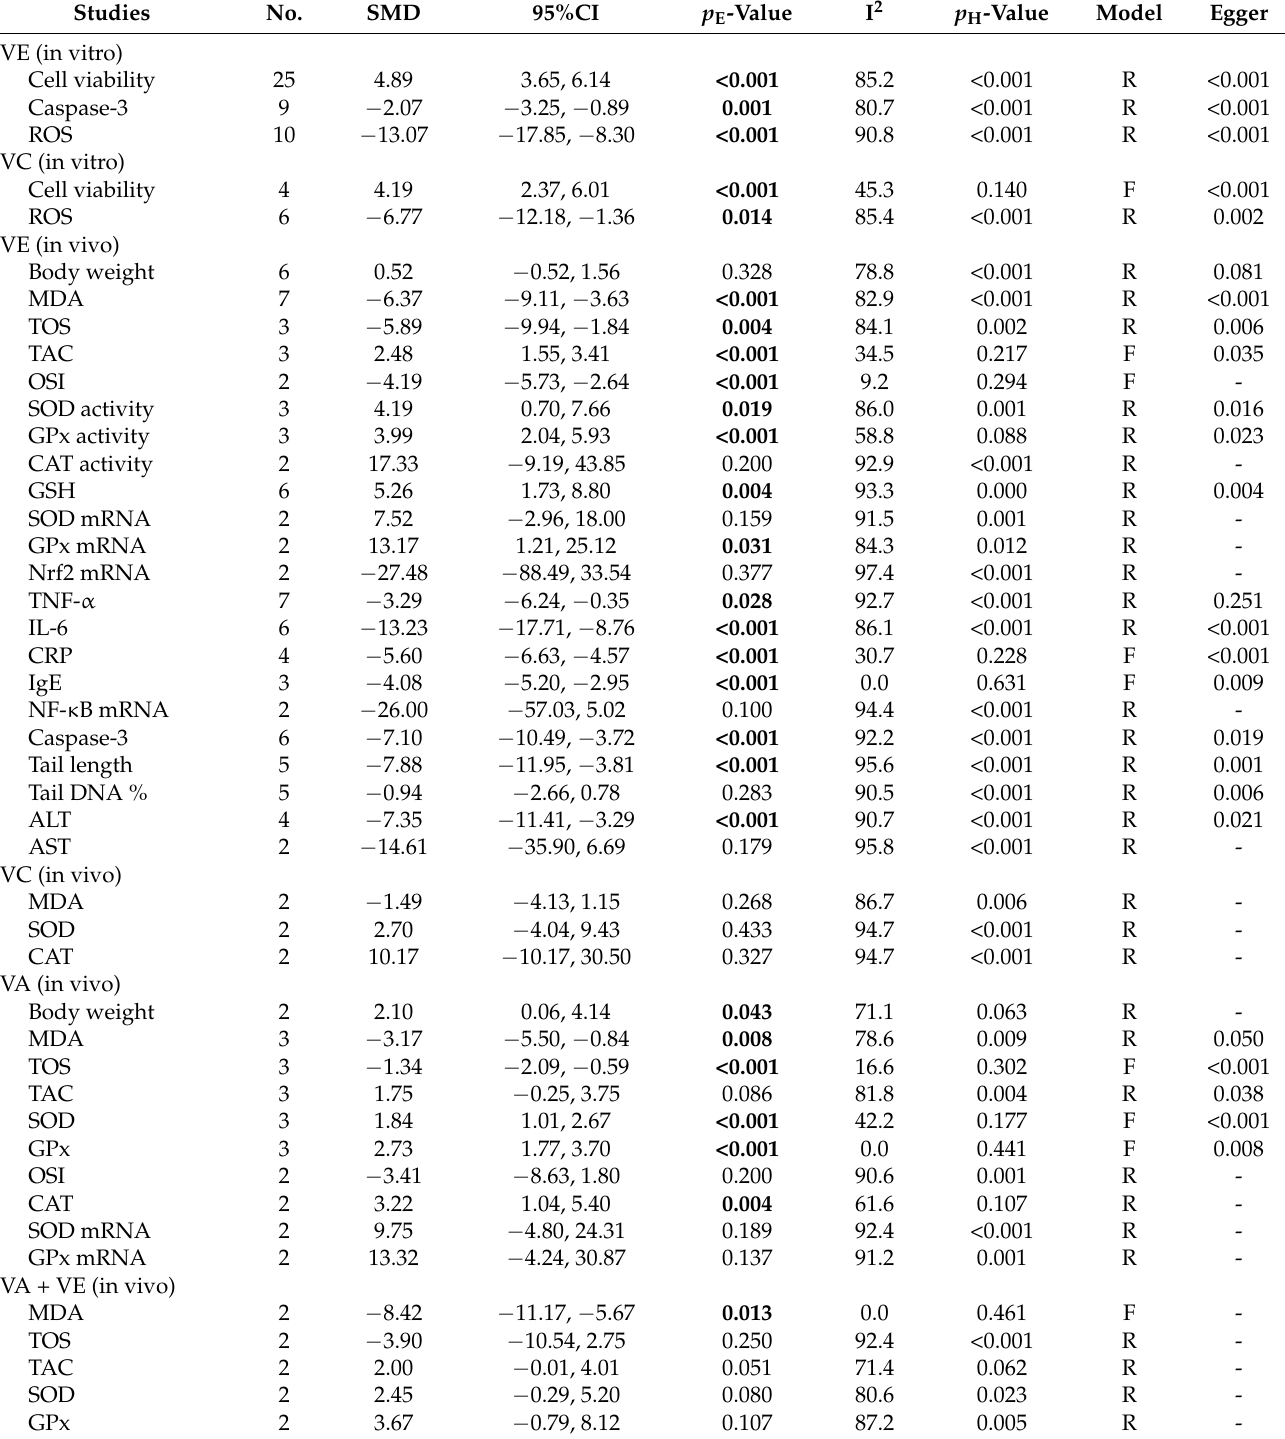
Table 3. Meta-analysis